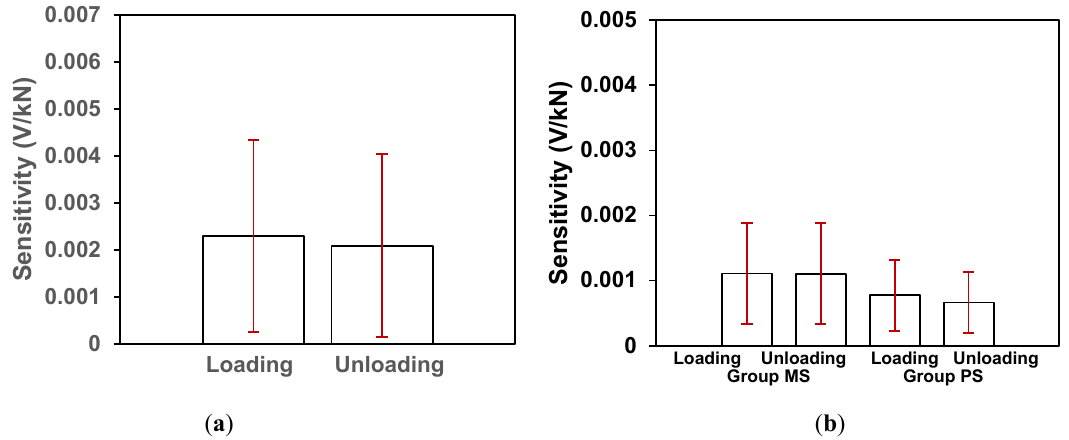
Figure 9. Average loading and unloading sensitivity in sample blocks impregnated with 0.1% bare CNTs using direct mixing method ( a ) and from the control Group MS (only modified tapioca starch but no CNTs) and Group PS (no CNTs and modified tapioca starch) ( b ). The vertical errors bar represents the standard deviations.